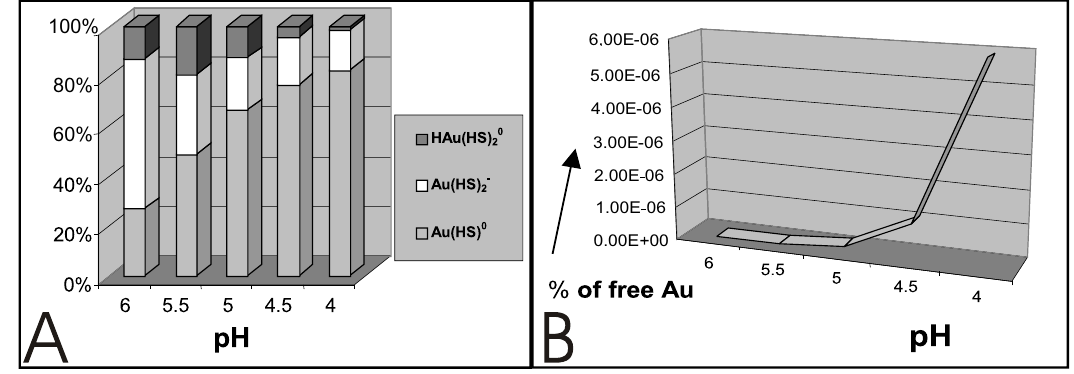
Fig. 2 – Speciation of Au with pH. (A) Variation in the concentration of the complexing sulfides species of gold in mol % versus pH. (B) Concentrations of free Au (%) versus pH.